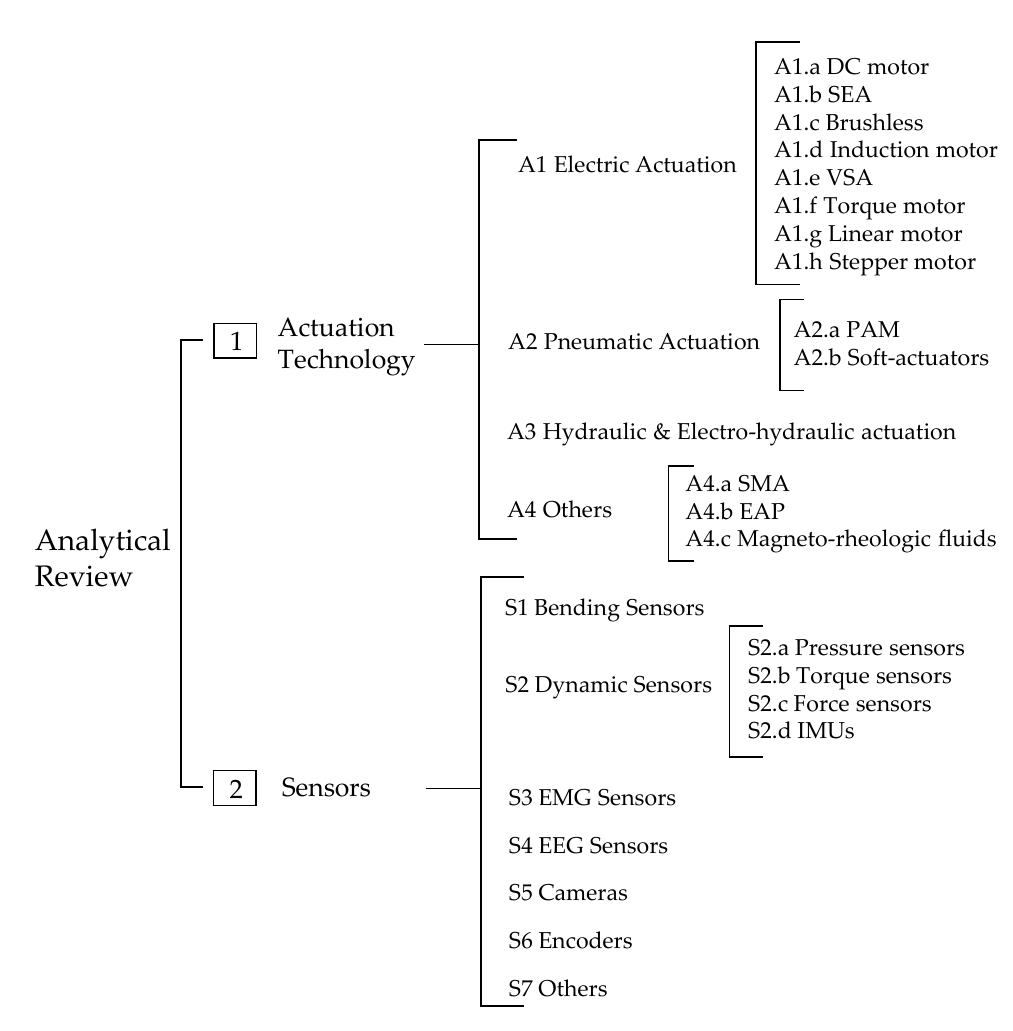
Figure A2. Adopted taxonomy for the analytical